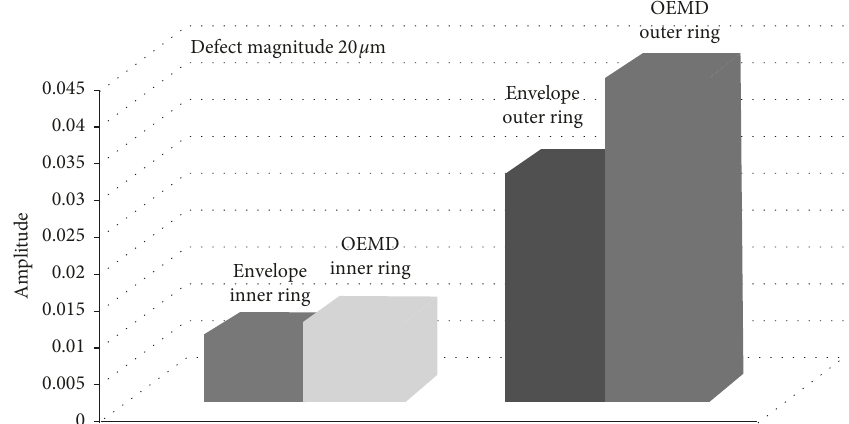
Figure 7: Comparison between the envelope and OEMD methods for inner ring and outer ring